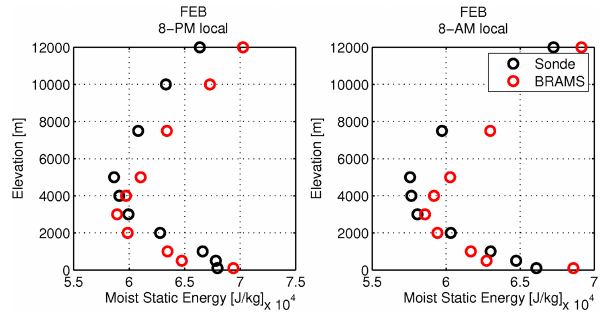
Figure C2. Comparison of model estimated mean moist static en- ergy with rawinsonde measurements. Manaus, February